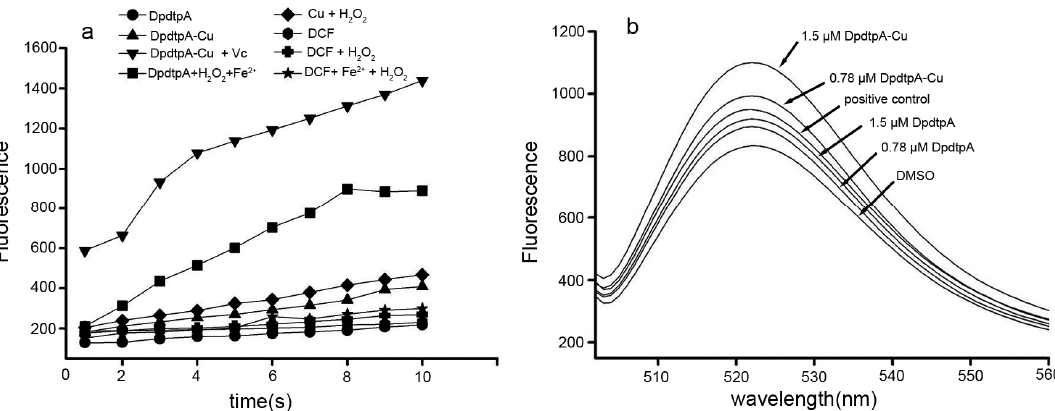
Figure 4. DpdtpA and its copper complex induced ROS production in vitro and in vivo. ( a ) In vitro ROS generation by iron or copper via a Fenton-like reaction; the ROS content was measured by DCF fluorescence; ( b ) In vivo, the ROS production after exposure of DpdtpA and its copper complex. DMSO was used as a